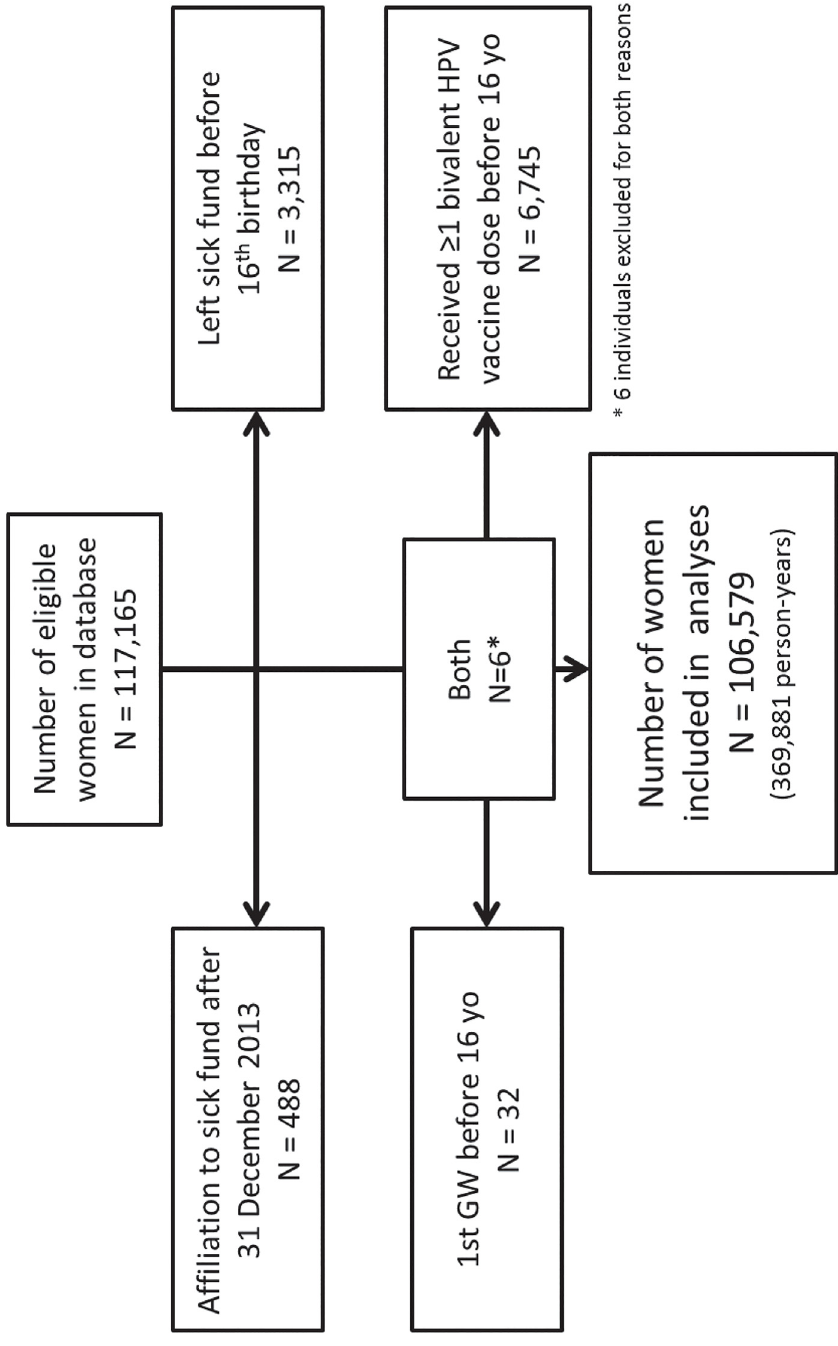
Fig 2. Vaccine effectiveness evaluation. Flow chart summarising the number of women and person-years of follow-up available for the main analysis, with reasons for exclusion.